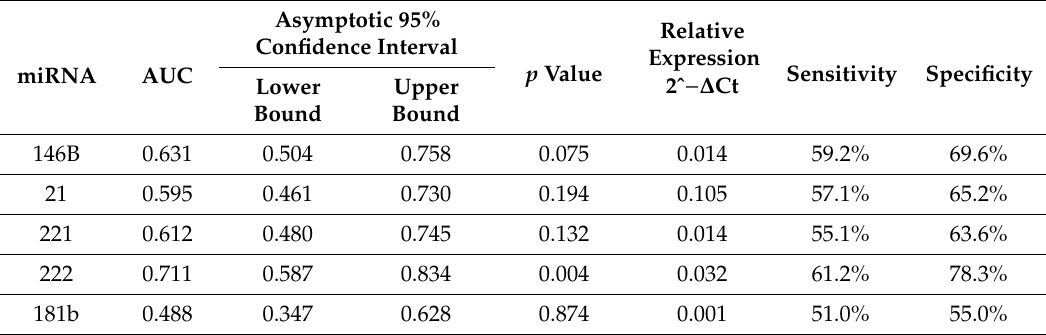
Table A5. ROC curves analysis for plasma miR-146b, miR-21, miR-221, miR-222 and miR-181b to discriminate papillary thyroid cancer from nodular